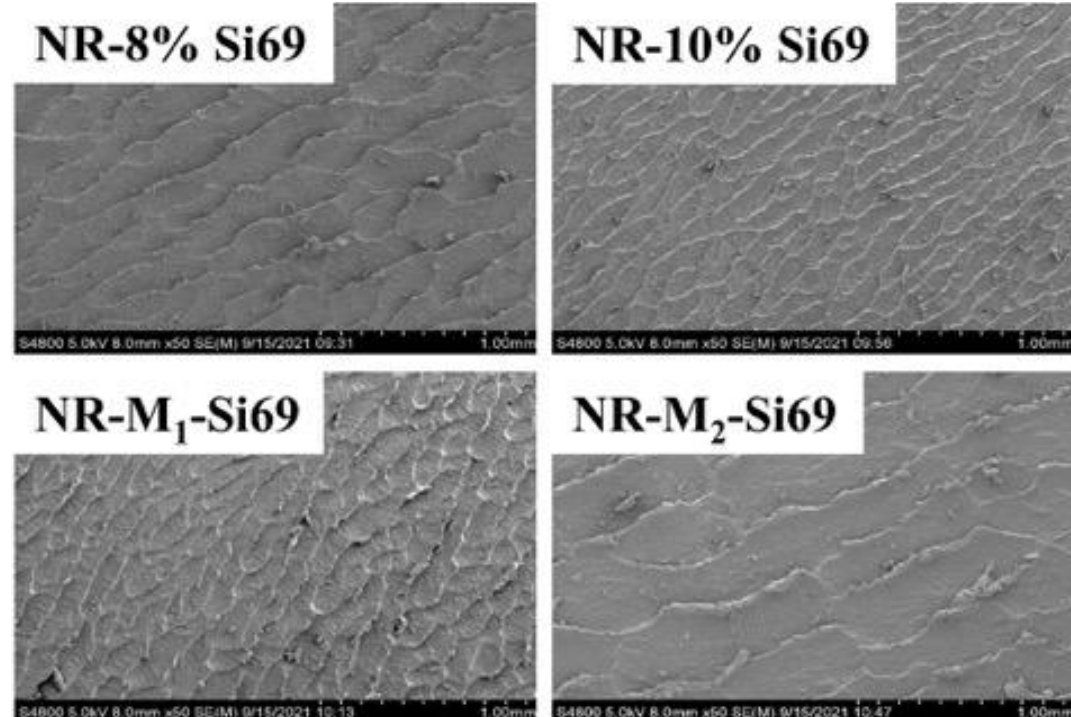
Figure 15. SEM images of Akron wear surface.